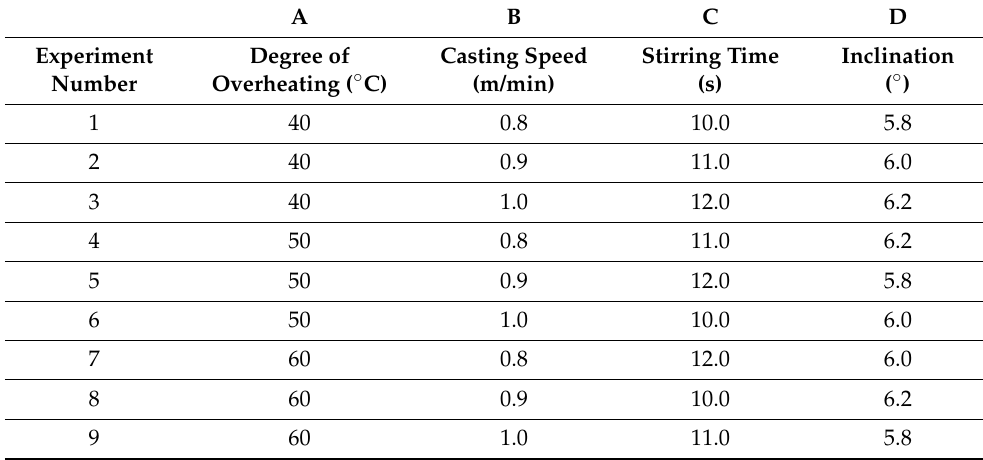
Table 1. Levels according to the L9 orthogonal array.